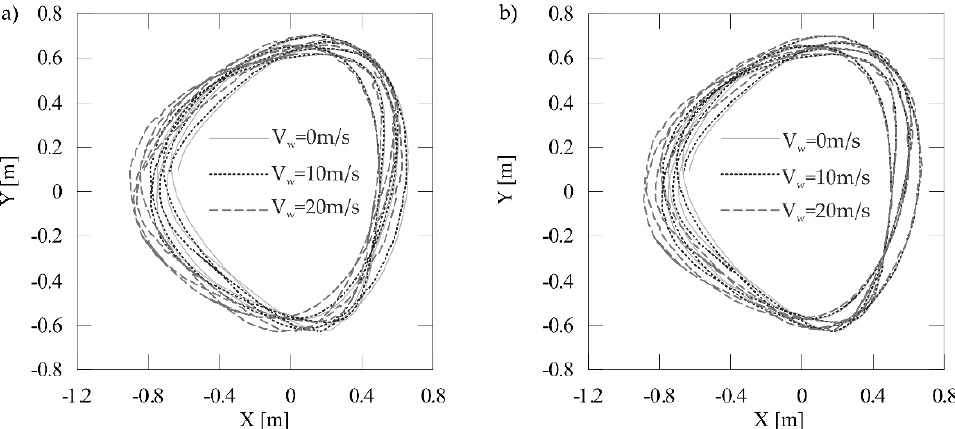
Figure 10. Projection of the trajectory of the carried load’s suspension point on the rotation plane for ( a ) the variable effective area and ( b ) fixed effective area.